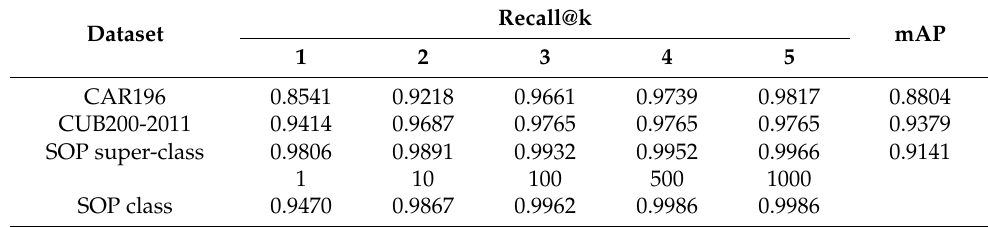
Table 2. Recall@k and mAP results from CUB200-2011, CARS196, and SOP datasets.